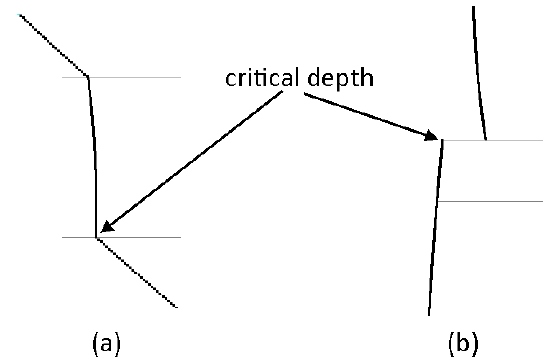
Figure 8. Critical points at the ends of segments. ( a ) Local minimum, specific energy with continuity. ( b ) Local maximum, specific energy without continuity